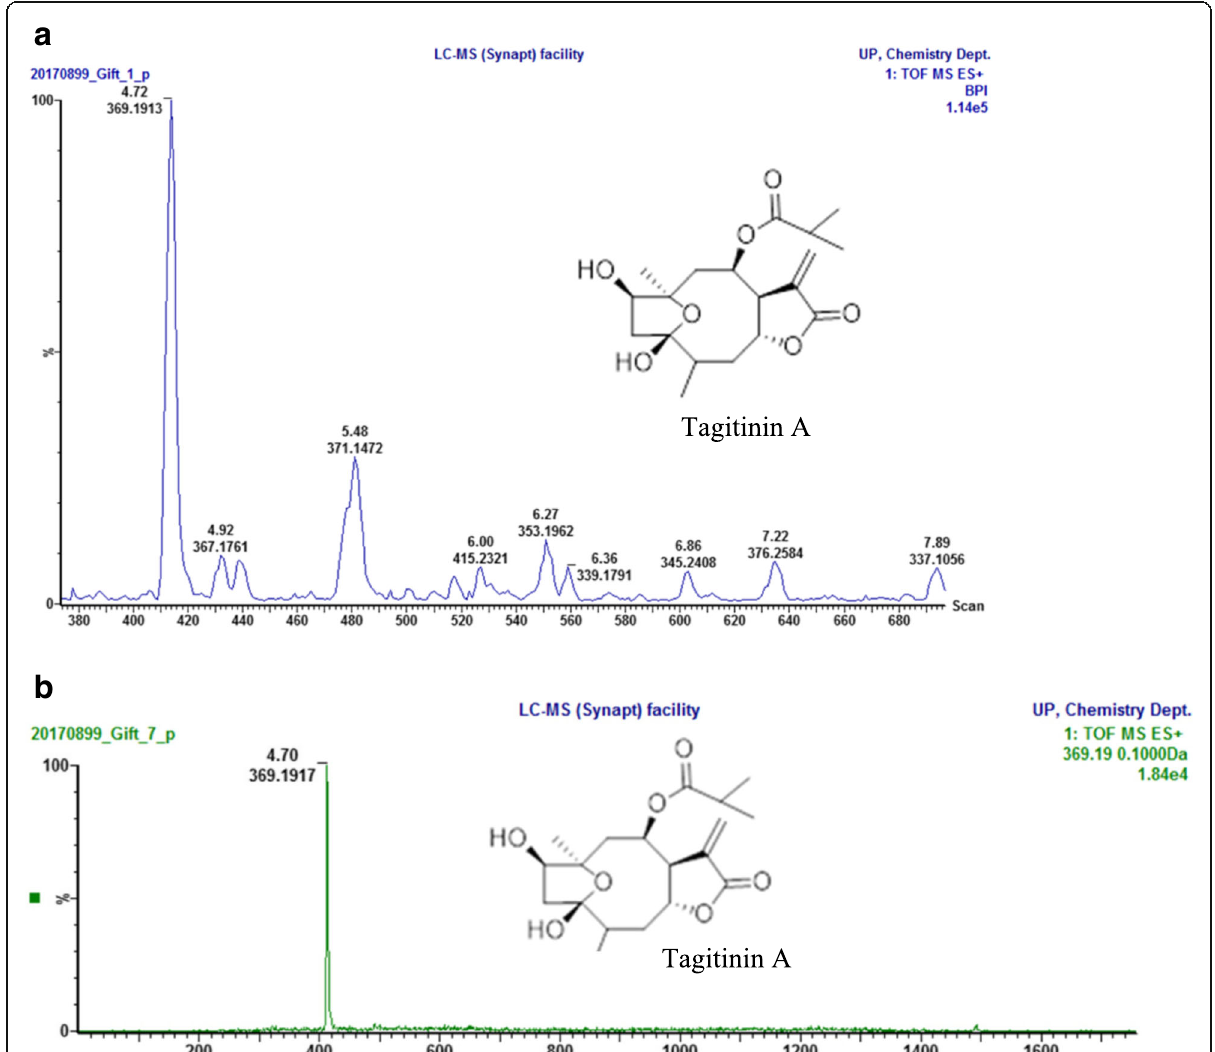
Fig. 2 a TIC MS (Total ion chromatogram) of chloroform fraction of T. diversifolia . b Extracted-ion chromatogram (EIC) of tagitinin A from an ethyl acetate fraction of T.